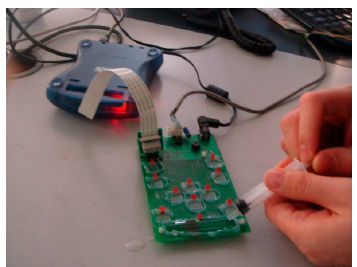
Figure A1. Mutual-capacitance.